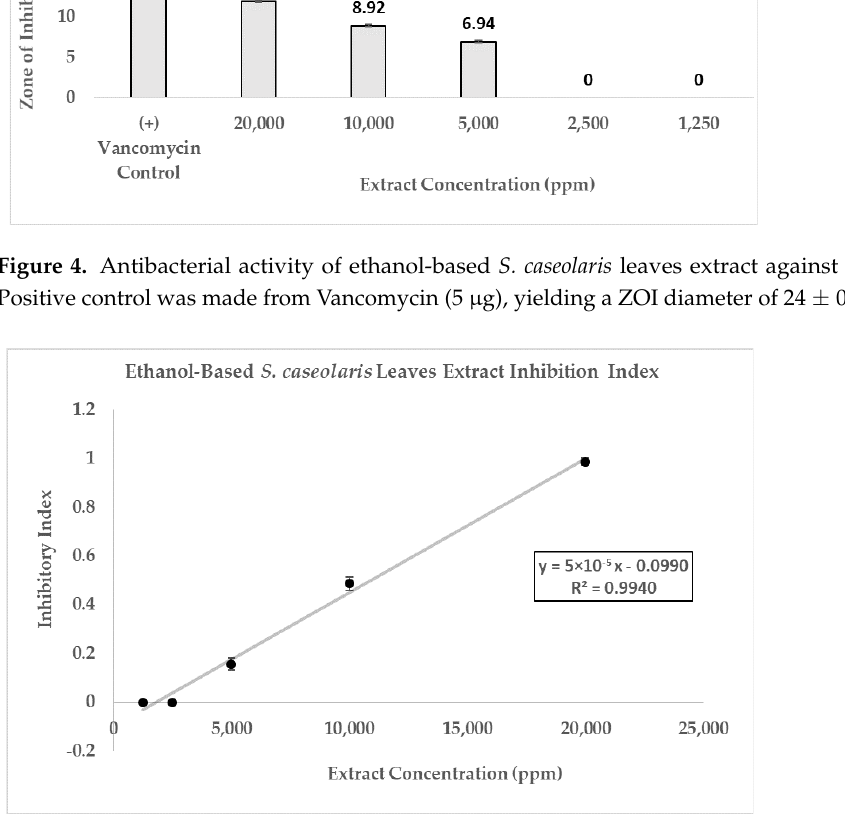
Figure 5. Inhibition index of ethanol-based S. caseolaris leaves extract against MRSA strain. Inhibition index of positive control Vancomycin (5 μg) was determined to be 3.0, using a calculation from its ZOI diameter.